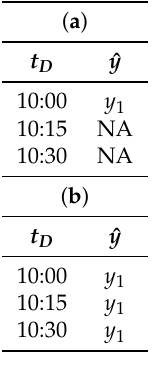
Table 2. Result of left join. ( a ) After applying the join. ( b ) After filling Non-Available (NA) values.